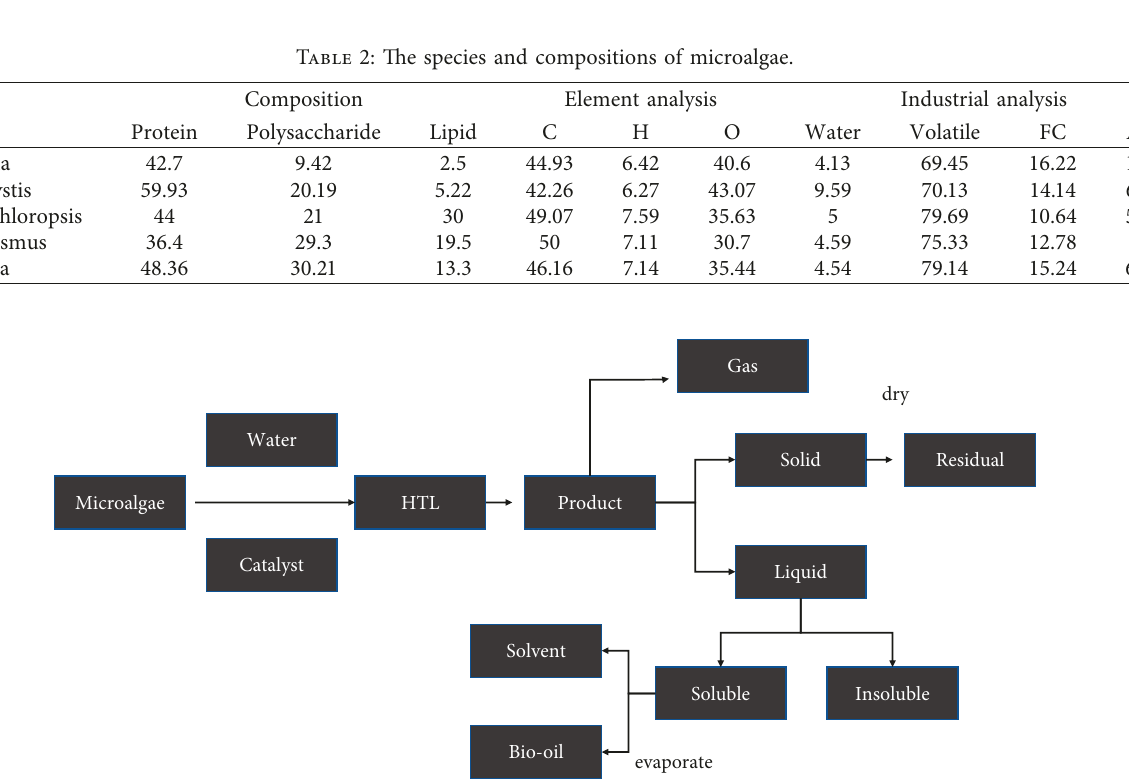
Figure 4: The schematic process of HTL for